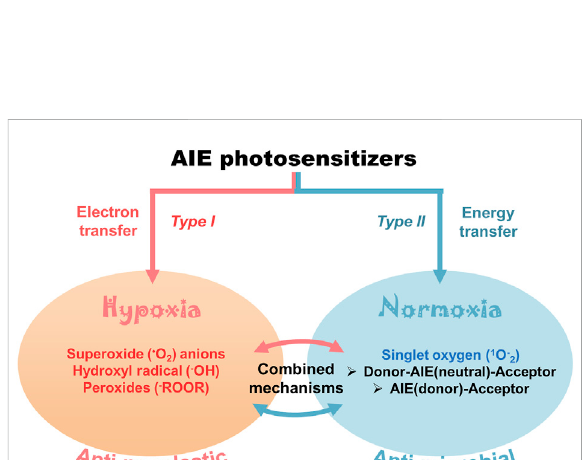
FIGURE 2 Cellular effects of AIE-photosensitizers: The AIE- photosensitizers are classi fi ed as type I and II according to their process of synthesis of ROS. Transfer of electrons at low oxygen concentration creates oxide free radicals ( type I photosensitization), while transfer of energy to the molecular oxygen generates singlet oxygen ( type II photosensitization). Often, electron transfer may happen from AIE-photosensitizer to oxygen in type II reactions forming superoxide anions. The type II photosensitization is subdivided into 1) Donor-AIE